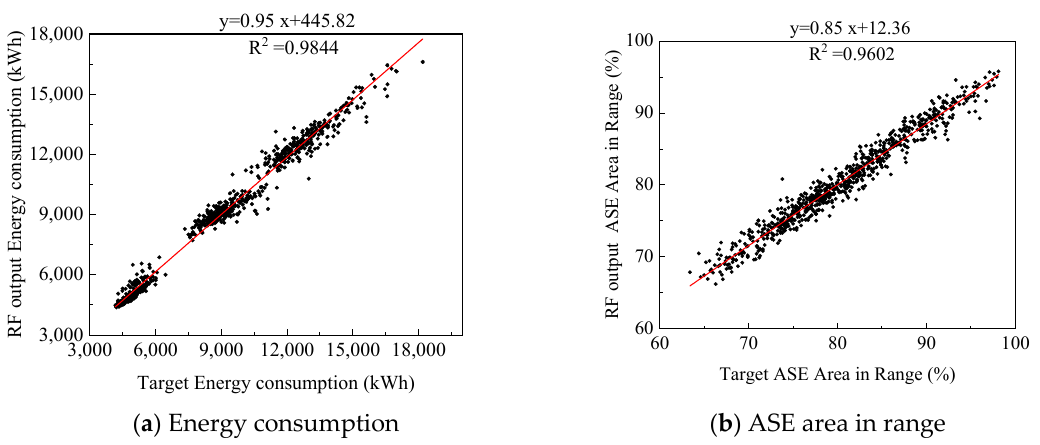
Figure 7. RF model output and target fitting diagram.